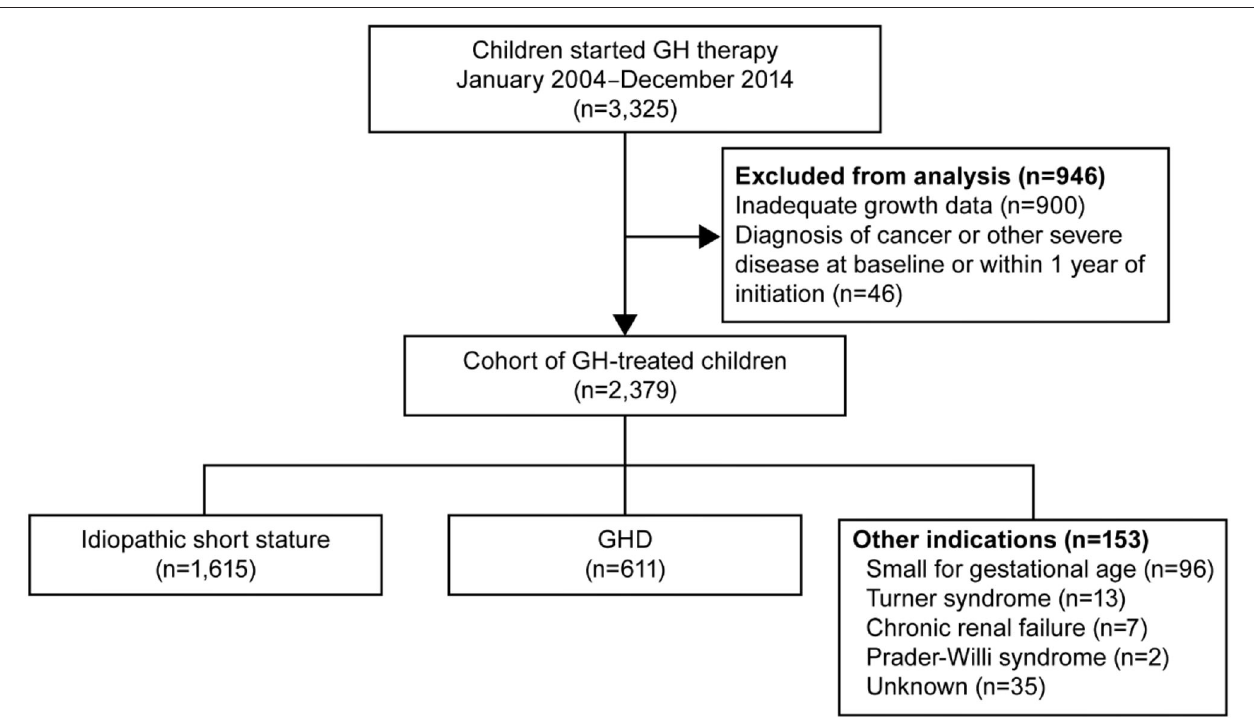
FIGURE 1 | Study flow diagram. GH, growth